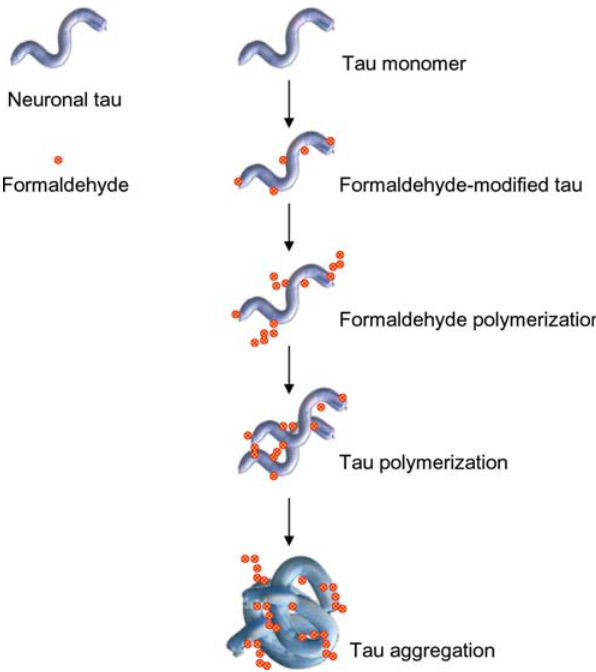
Figure 11. A putative mechanism for protein tau to aggregate in a formaldehyde solution. Formaldehyde reacts with the amino and thiol groups, and then formaldehyde polymerizes and induces tau to